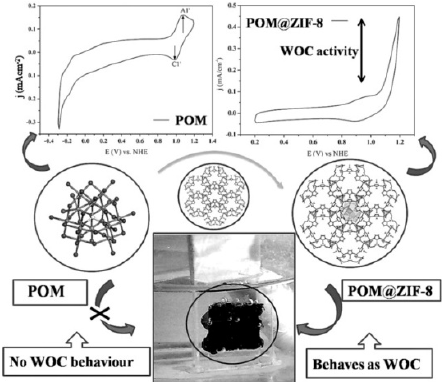
Figure 13. Encapsulation of an inactive Keggin POM in ZIF-8 to become an active oxygen evolution reaction (OER) catalyst. Reprinted with permission from [137]. Copyright (2018), John Wiley and Sons.